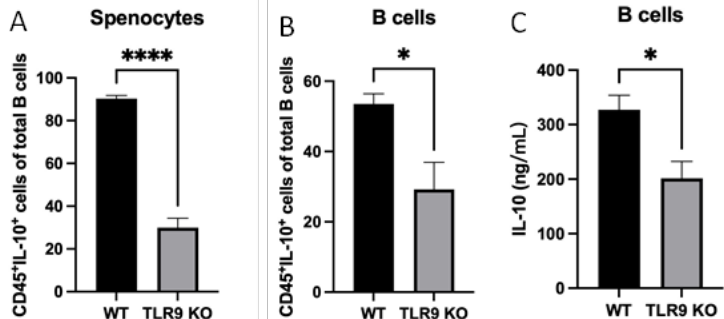
Figure 3. Under P. gingivalis stimulation for 24 h, the CD45 + IL-10 + cells of splenocytes and B cells, and secreted IL-10 protein levels of B cells isolated from both pre-immunized wild-type and TLR9 knockout mice were calculated. ( A , B ) The percentage of CD45 + IL-10 + cells among splenocytes ( A ) and B cells ( B ) were calculated based on cell immunocytochemistry staining. ( C ) The secreted IL-10 protein levels in the supernatants were measured by a mouse IL-10 enzyme-linked ELISA kit using a 1:10 assay diluent in PBST. The data were shown as mean ± SD; significance calculated by unpaired t -test was indicated as * p < 0.05, **** p < 0.0001 (n = 5).